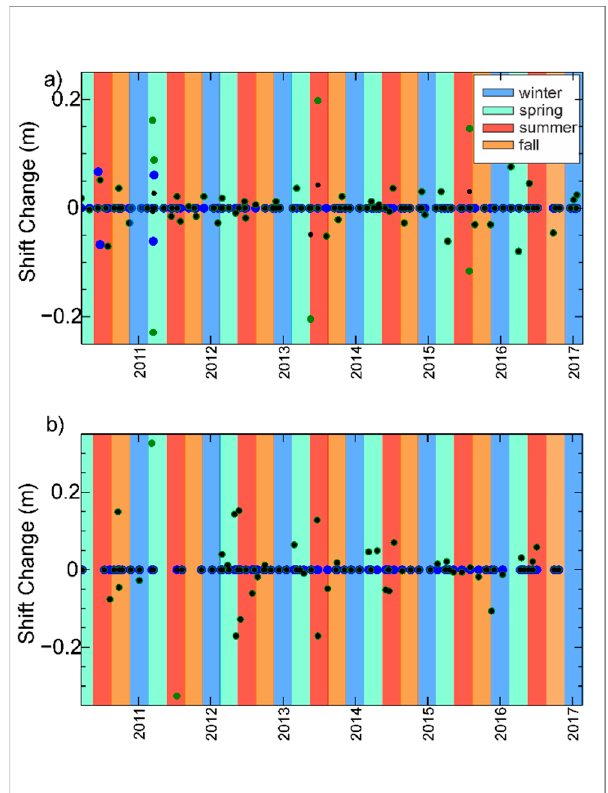
Figure 15. Shift variation value as function of the season. Black, green and blue dots represent the shift values applied to the section, channel, and overbank control areas, respectively. ( a ) Cedar River at Osage; ( b ) Little Sioux River near